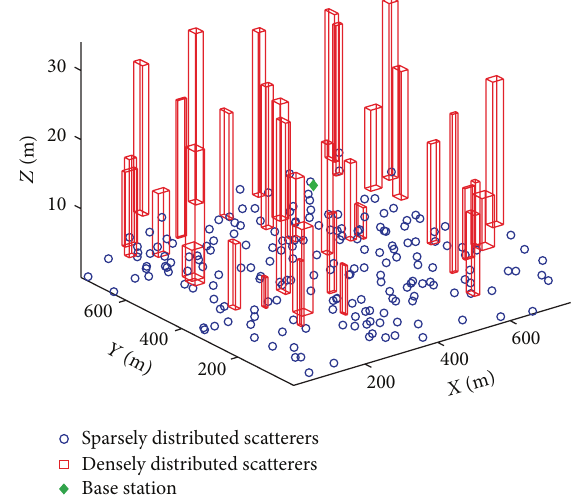
Figure 2: Propagation graph representation of the BS and densely and sparsely distributed scatterers for simulations.